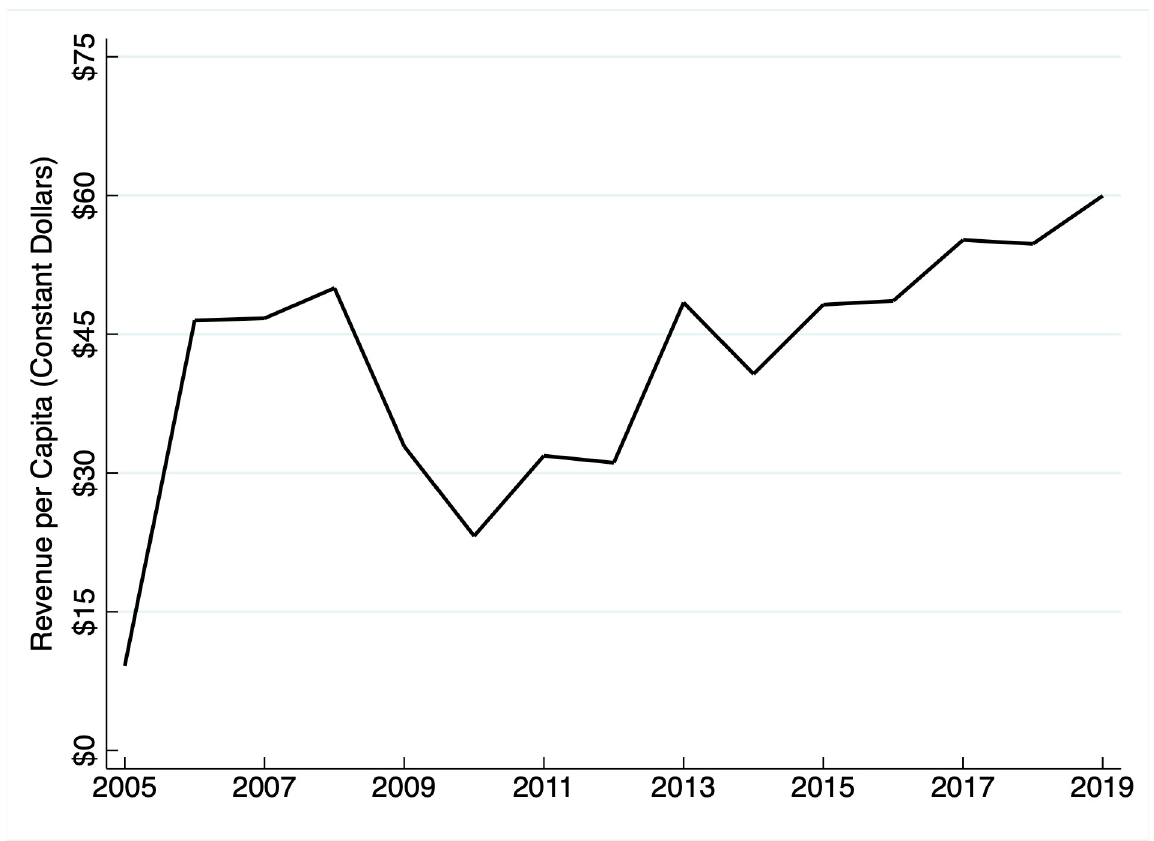
Fig 1. California mental health services tax revenue per capita. Author’s calculations based on data reported in “Promises Still to Keep: A Decade of the Mental Health Services Act” from California’s Little Hoover Commission, annual expenditure reports from the California Health and Human Service Agency, and current population estimates from the United States Census Bureau. Amounts adjusted using the Consumer Price Index.